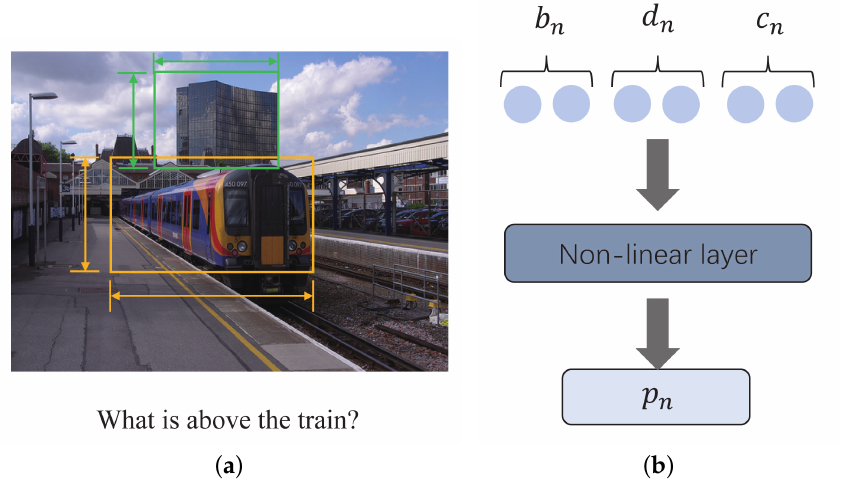
Figure 4. ( a ) An example of a question in relation to the positional relationship of objects. ( b ) Flowchart of the position embedding P n